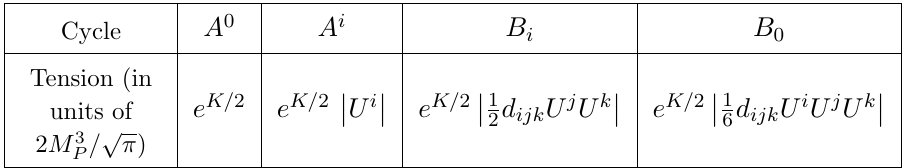
Table 5. DBI tensions of domain walls formed by D5-branes wrapping